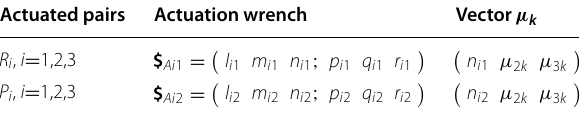
Table 1 Corresponding actuation wrenches and vector µ k Actuated